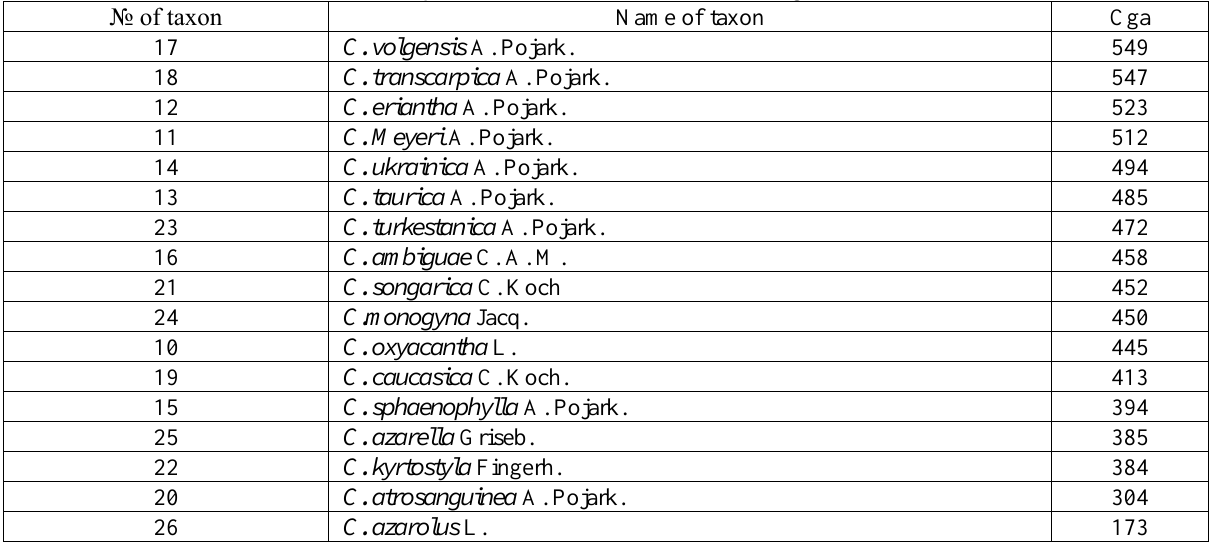
Hierarchical row of the Oxyacanthae Zbl. section genus Crataegus L. on vegetative grounds